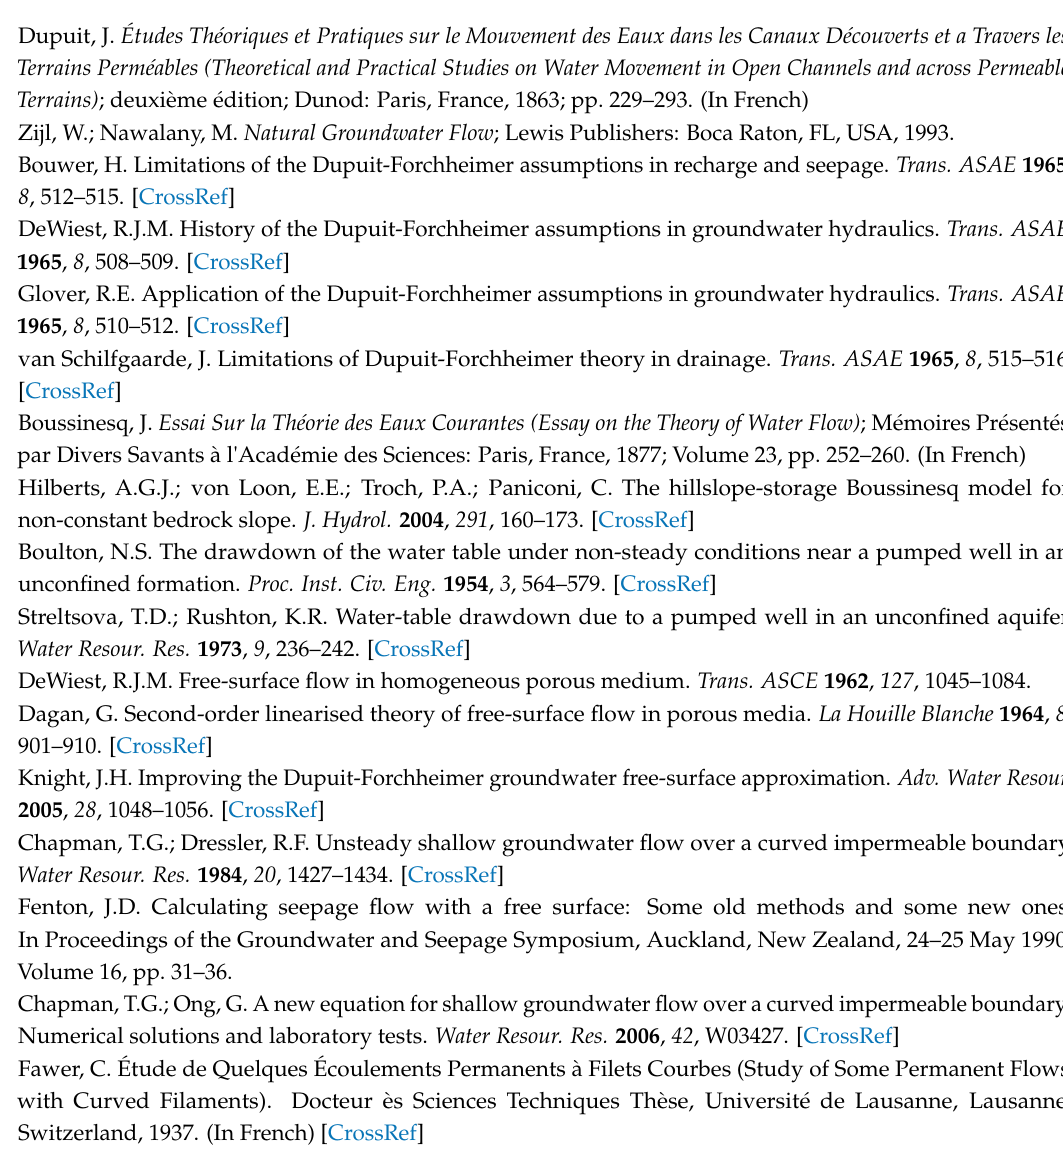
Figure A1. Schematic diagram for a gradually-varied groundwater flow over sloping planar bedrock.